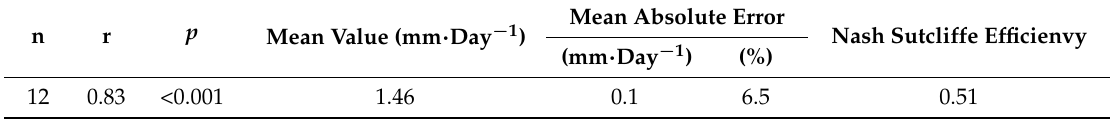
Table 3. Peak river flow model evaluation.